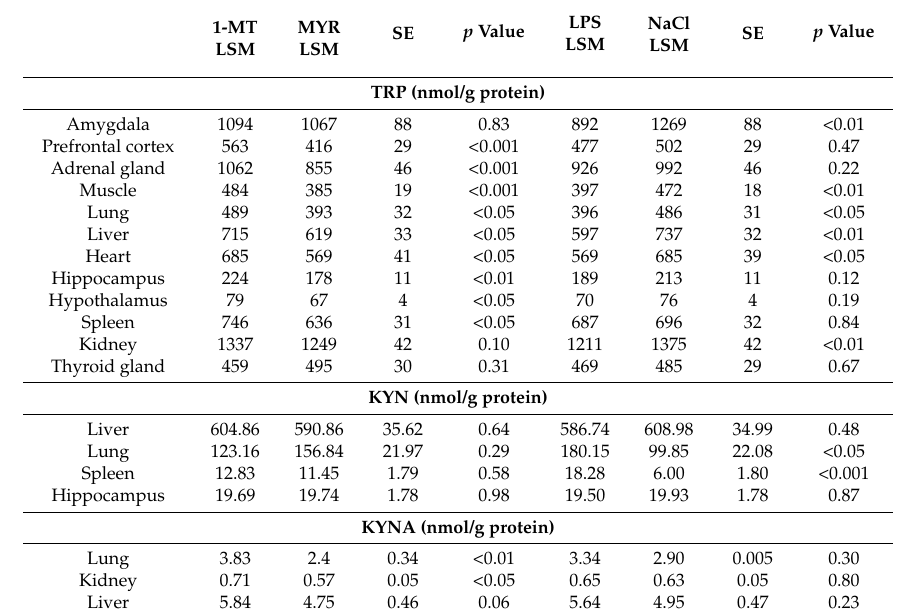
Table 2. Pairwise comparisons of 1-MT vs. MYR and of LPS vs. NaCl in peripheral and brain tissues using Tukey–Kramer